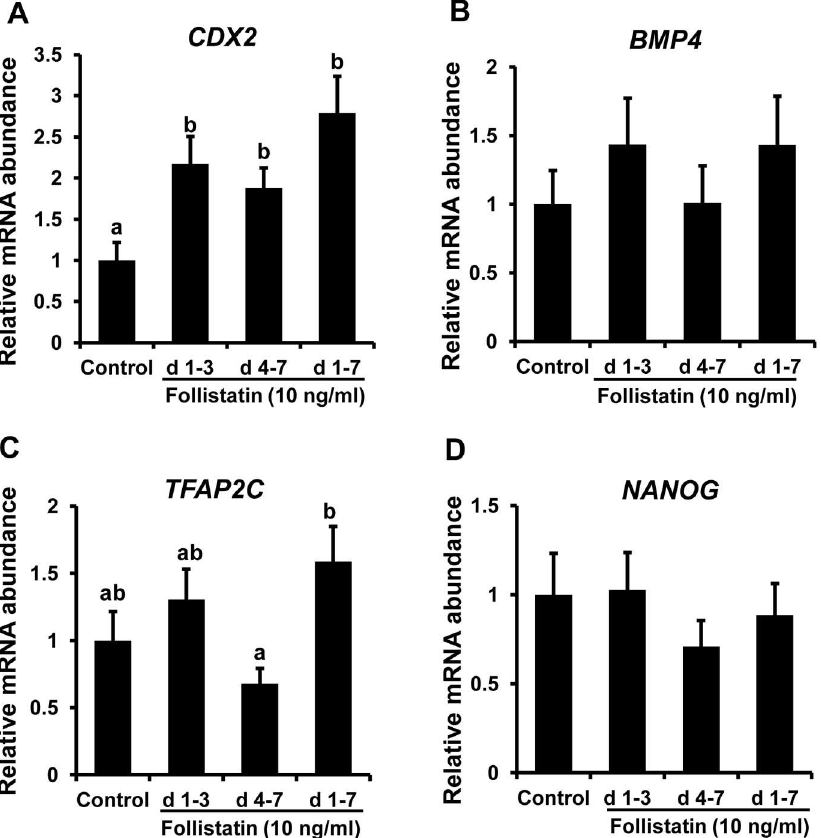
Fig 4. Stage-specific effects of follistatin treatment on mRNA expression of genes involved in TE cell lineage determination ( CDX2 , TFAP2C and BMP4 ) and ICM pluripotency ( NANOG ) in bovine d7 blastocysts. Effect of exogenousfollistatin supplementation duringpre-compaction (d 1–3), peri-/post- compaction (d 4–7) and entire period (d 1–7) of in vitro embryo culture on; (A) CDX2 , (B) BMP4 , (C) TFAP2C and (D) NANOG transcript abundance as determined by real-time PCR in bovineblastocysts collectedon d 7 after insemination. Values are shown as the mean ± SEM of the data collectedfrom 6 replicates (n = 25–30 zygotes/treatment in each replicate). Valuesaccompaniedwith different letters across the treatments indicate significantdifference ( P <